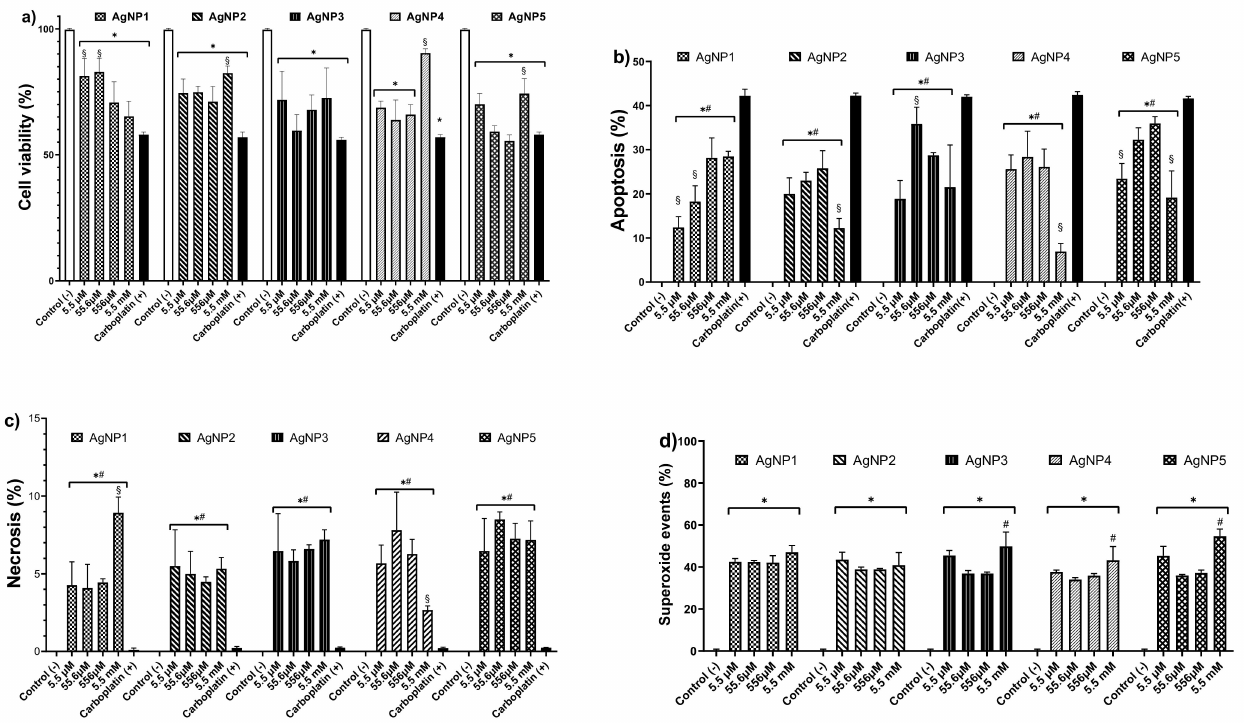
Figure 3. Cytotoxic effect on HCT-15 cultures after 24 h exposure to 5.5 µ M, 55.6 µ M, 556 µ M and 5.5 mM of AgNP1– AgNP5. ( a ) Cell viability, ( b ) apoptosis, ( c ) necrosis, and ( d ) mitochondrial superoxide. * represents statistically significant differences ( p < 0.05) compared with negative control, # represents statistically significant differences ( p < 0.05) compared with carboplatin, and § represents statistically significant differences ( p < 0.05) between the assessed concentrations of each AgNP